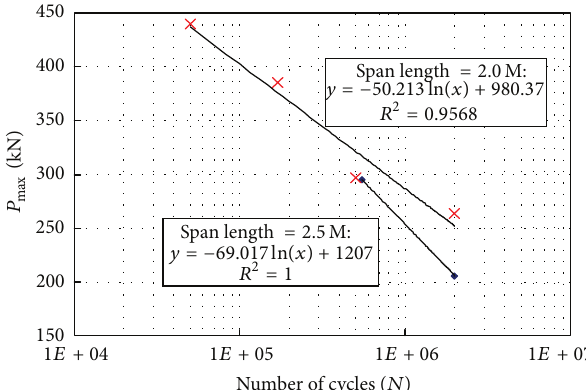
Figure 11: Correlation between the number of load cycles and maximum load.